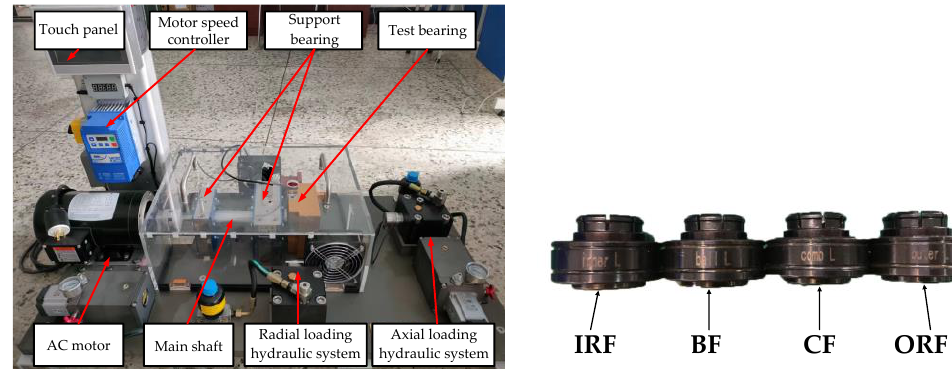
Figure 18. Rolling Bearing Fault Diagnosis Test Bench.